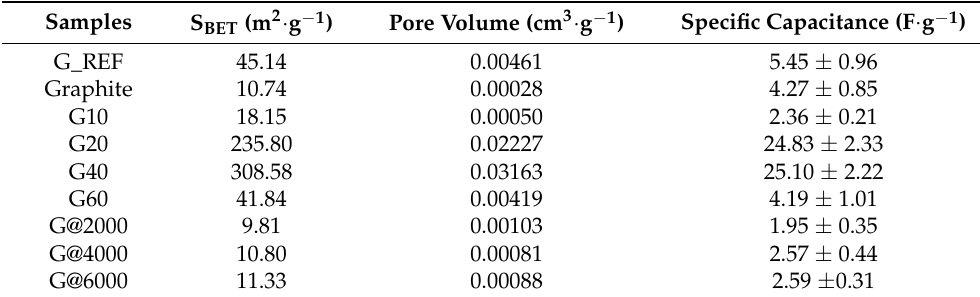
Table 3. Surface area, pore volume, and specific capacitance determined for commercial graphene (G_REF), commercial graphite, and commercial graphite subjected to milling using a Retsch